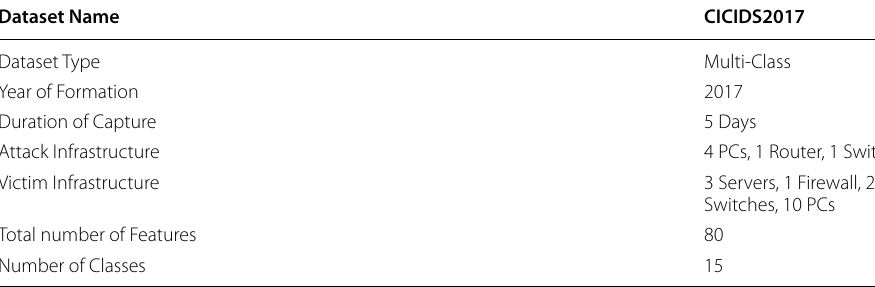
Table 3 Details of the CICIDS2017